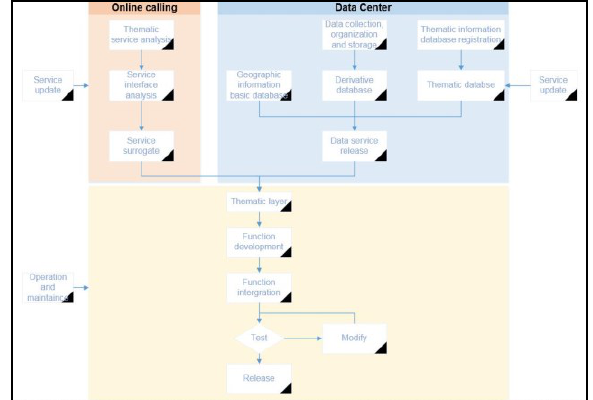
Figure 3. System technical